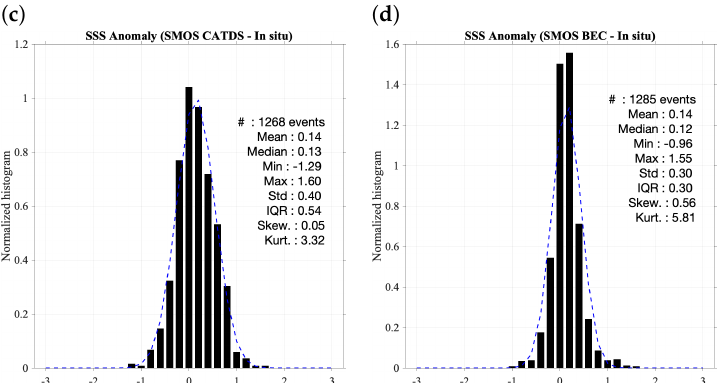
Figure 13. Histograms of SSS anomalies (satellite − in-situ) using ( a ) SMAP JPL, ( b ) SMAP RSS, ( c ) SMOS CATDS, ( d ) SMOS